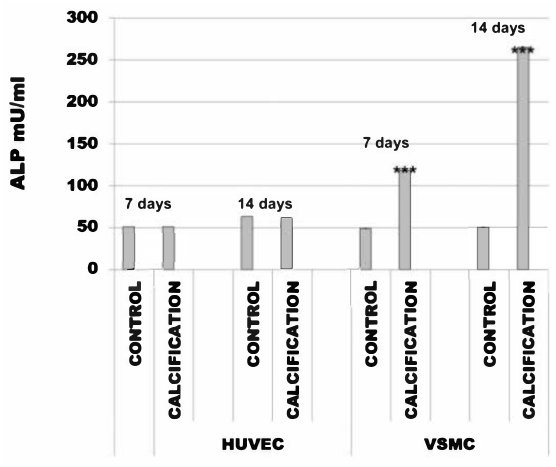
Figure 2. Alkaline phosphatase activity (ALP) in human umbilical vein endothelial cells (HUVEC) and vascular smooth muscle cells (VSMC) cells treated with calcification medium. Note that calcifica- tion does not alter ALP activity in HUVEC cells, *** p < 0.001. 3.4. Induction of Calcification in HUVEC and VSMC Cells Led to Increased Expression of OC, OPN and RUNX2